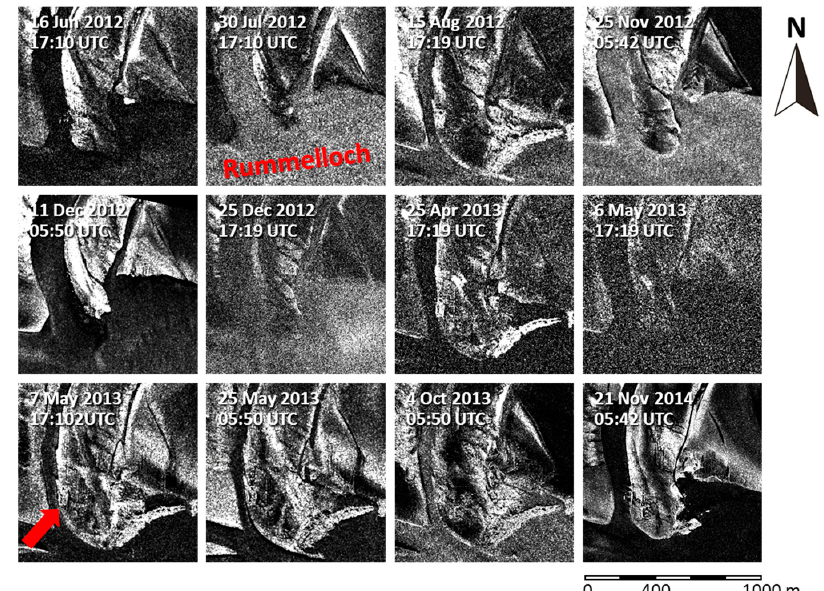
Figure 6. Examples of (1 km × 1 km) TerraSAR-X imagery of the area of interest marked by the right square in Figure 3. The red arrow in the lower left panel denotes cultural traces, whose imprints can be seen on some of the SAR images, and best on the ‘staring spotlight’ scene on the lower right. © DLR 2012, 2013, 2014.